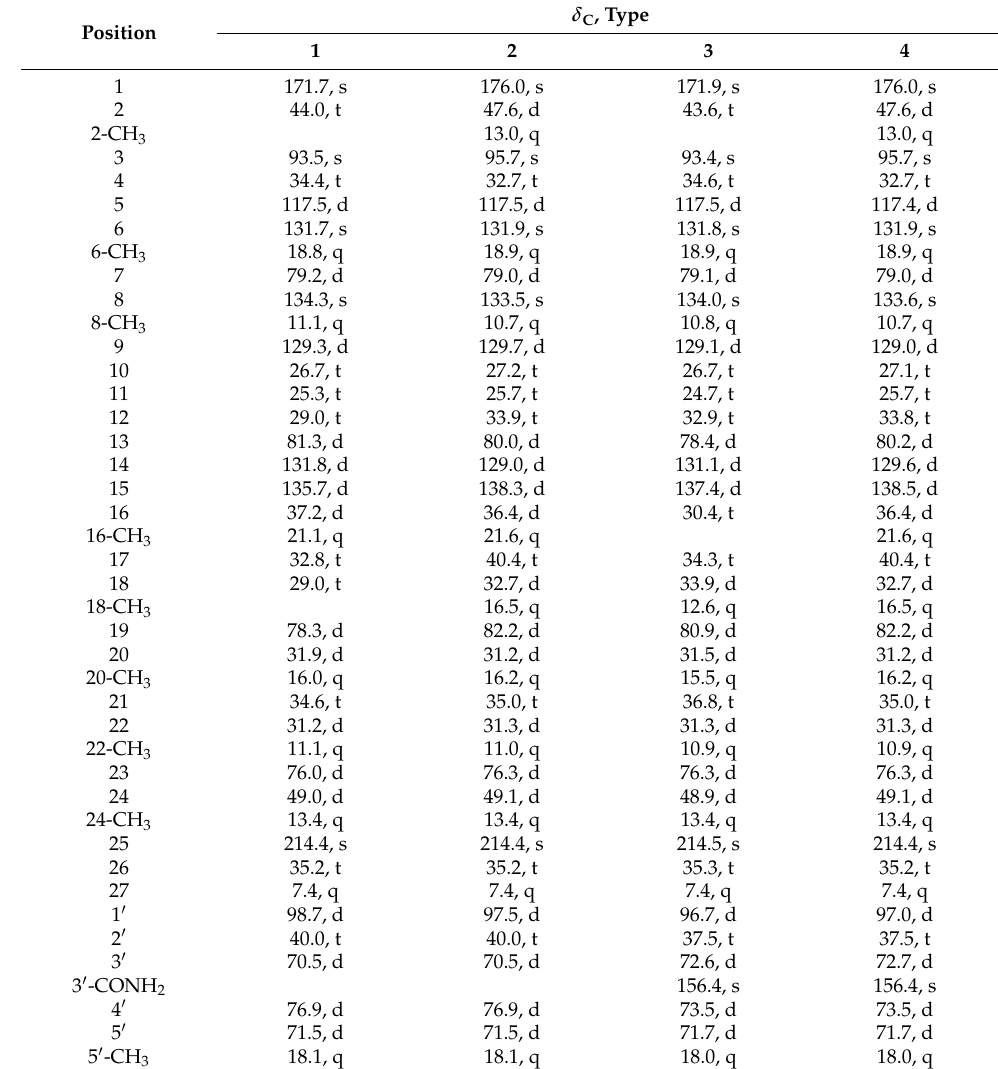
Table 2. 13 C (150 MHz) NMR Data of Compounds 1 – 4 in d 6